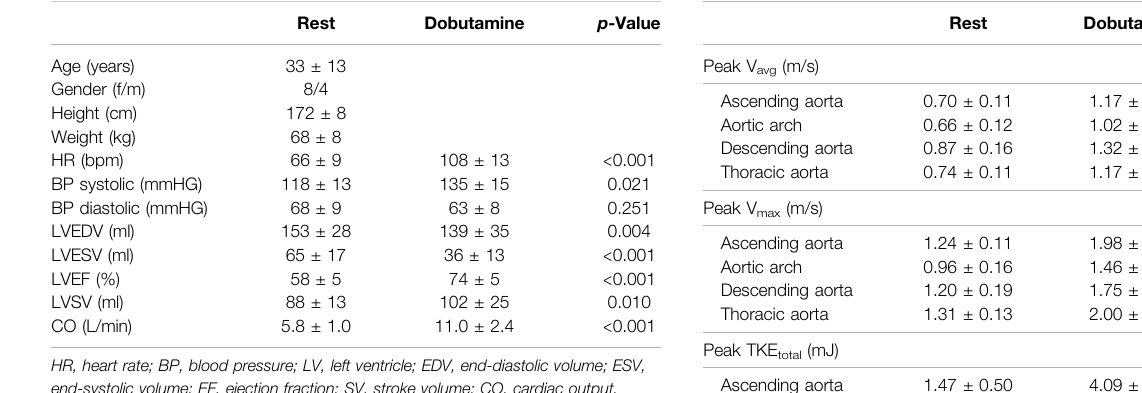
TABLE 1 | Demographic and clinical parameters.